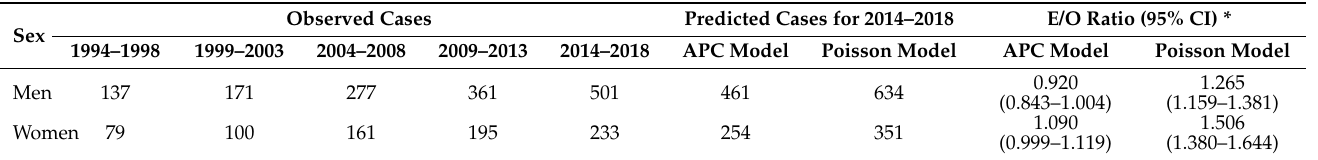
Table 1. Observed number of malignant mesothelioma cases during the 1994–2018 period and comparison with the number of cases predicted using the age–period–cohort (APC) model and Poisson regression model for 2014–2018.